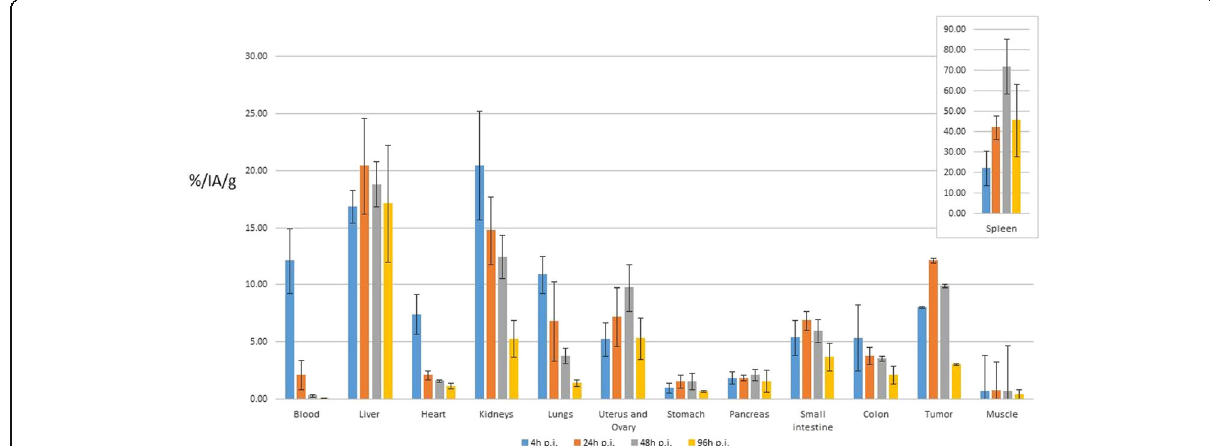
Fig. 4 Biological organ kinetic of the radiolabeled antibody corrected for radioisotope physical decay. For each time point, color bars represent the average percent of injected activity per gram of tissue (%IA/g)± 1SD